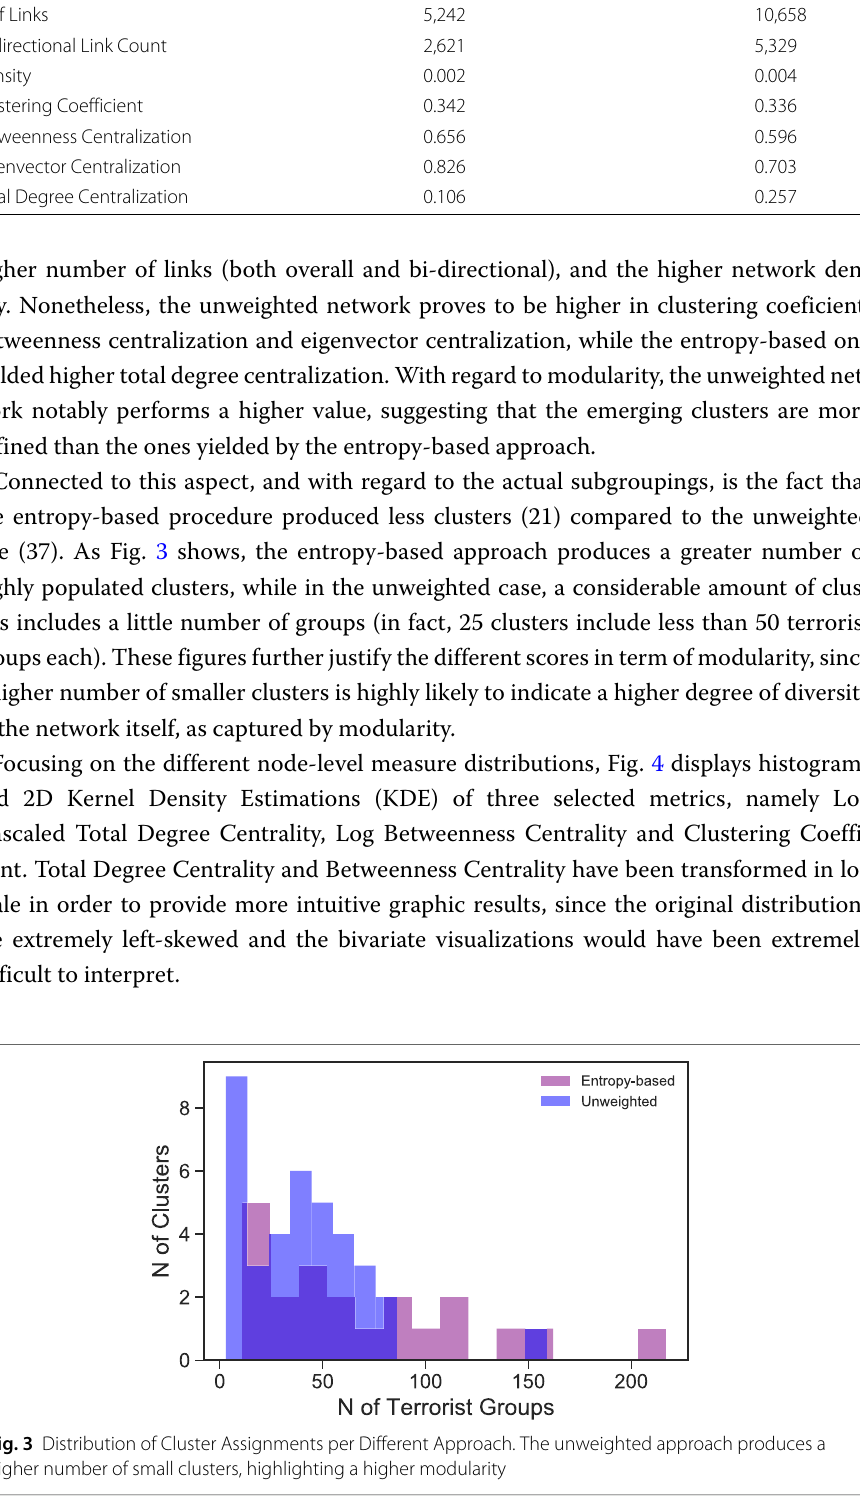
Table 3 Network structural and topological characteristics for both approaches Unweighted Entropy-based Best k 2 4 Modularity 0.805 0.390 N of Links 5,242 10,658 Bi-directional Link Count 2,621 5,329 0.002